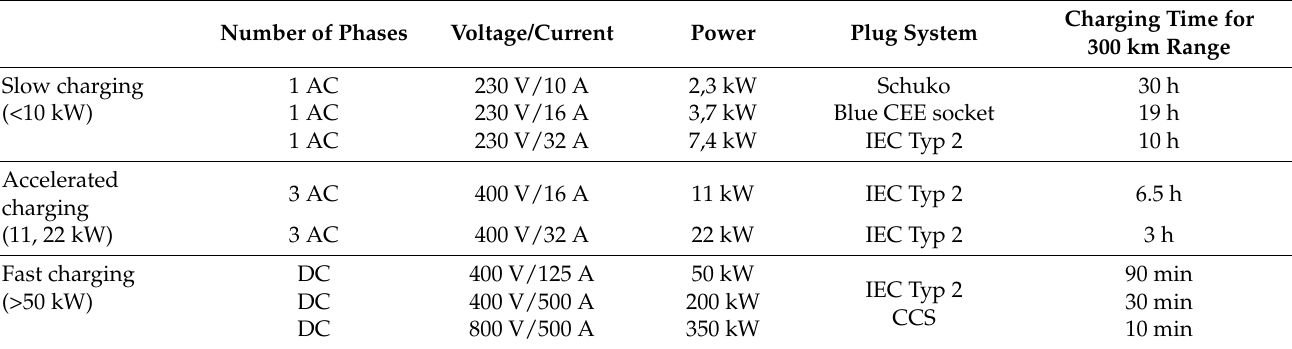
Table 1. Common charging methods and charging times for electric cars [60].